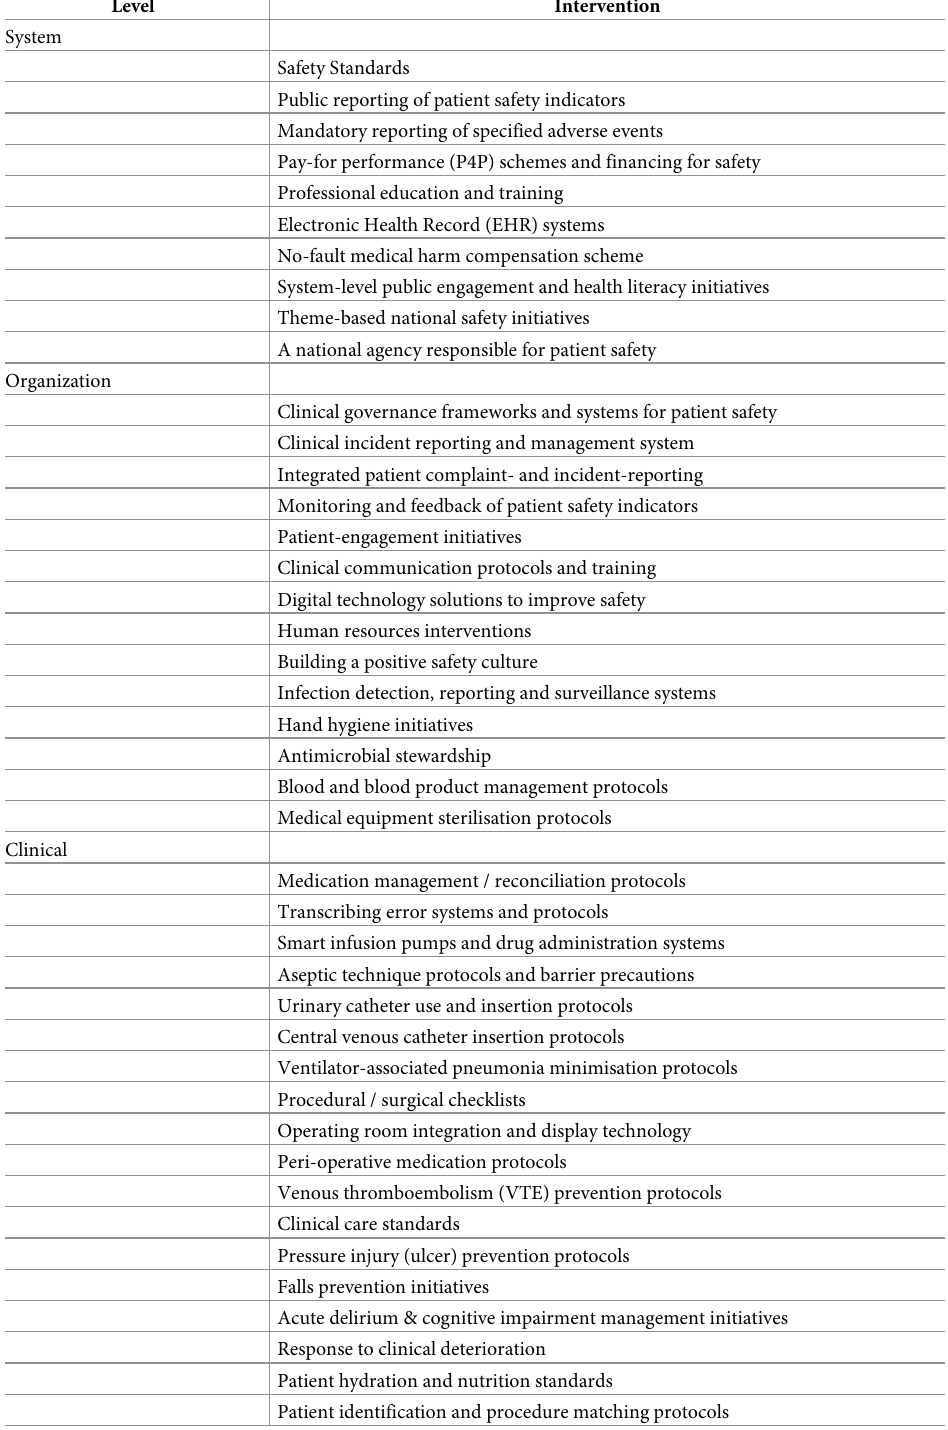
Table 1. 42 patient safety